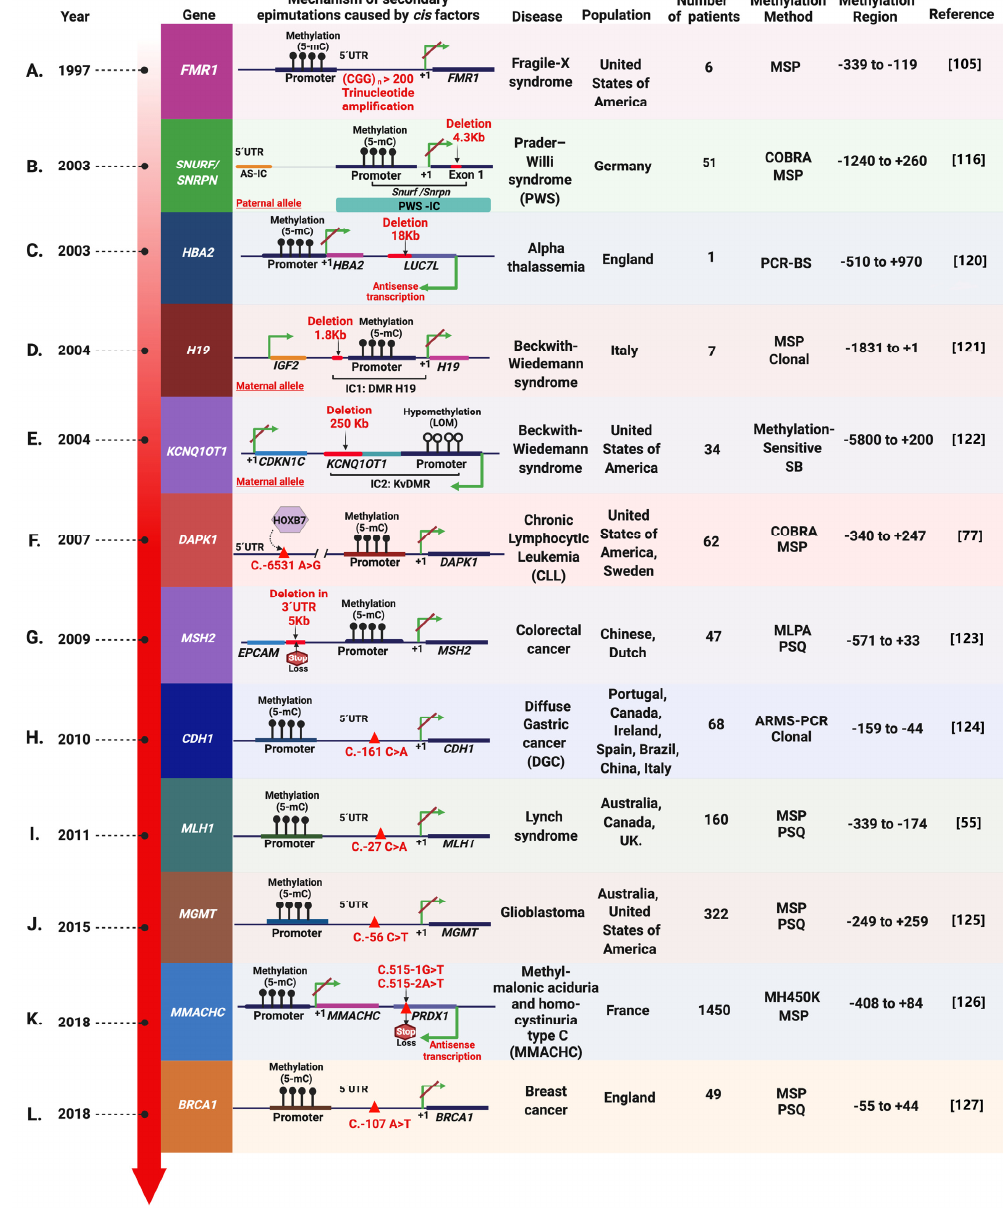
Figure 5. Chronological reports of secondary epimutations causing promoter methylation in cancer and other diseases [55,77,105,116,120–127]. Red color indicates the cis -acting factor that results in secondary epimutation. The details of each disease and their pathogenic secondary epimutations are described in the text. Green arrows indicate the site +1 (ATG) of